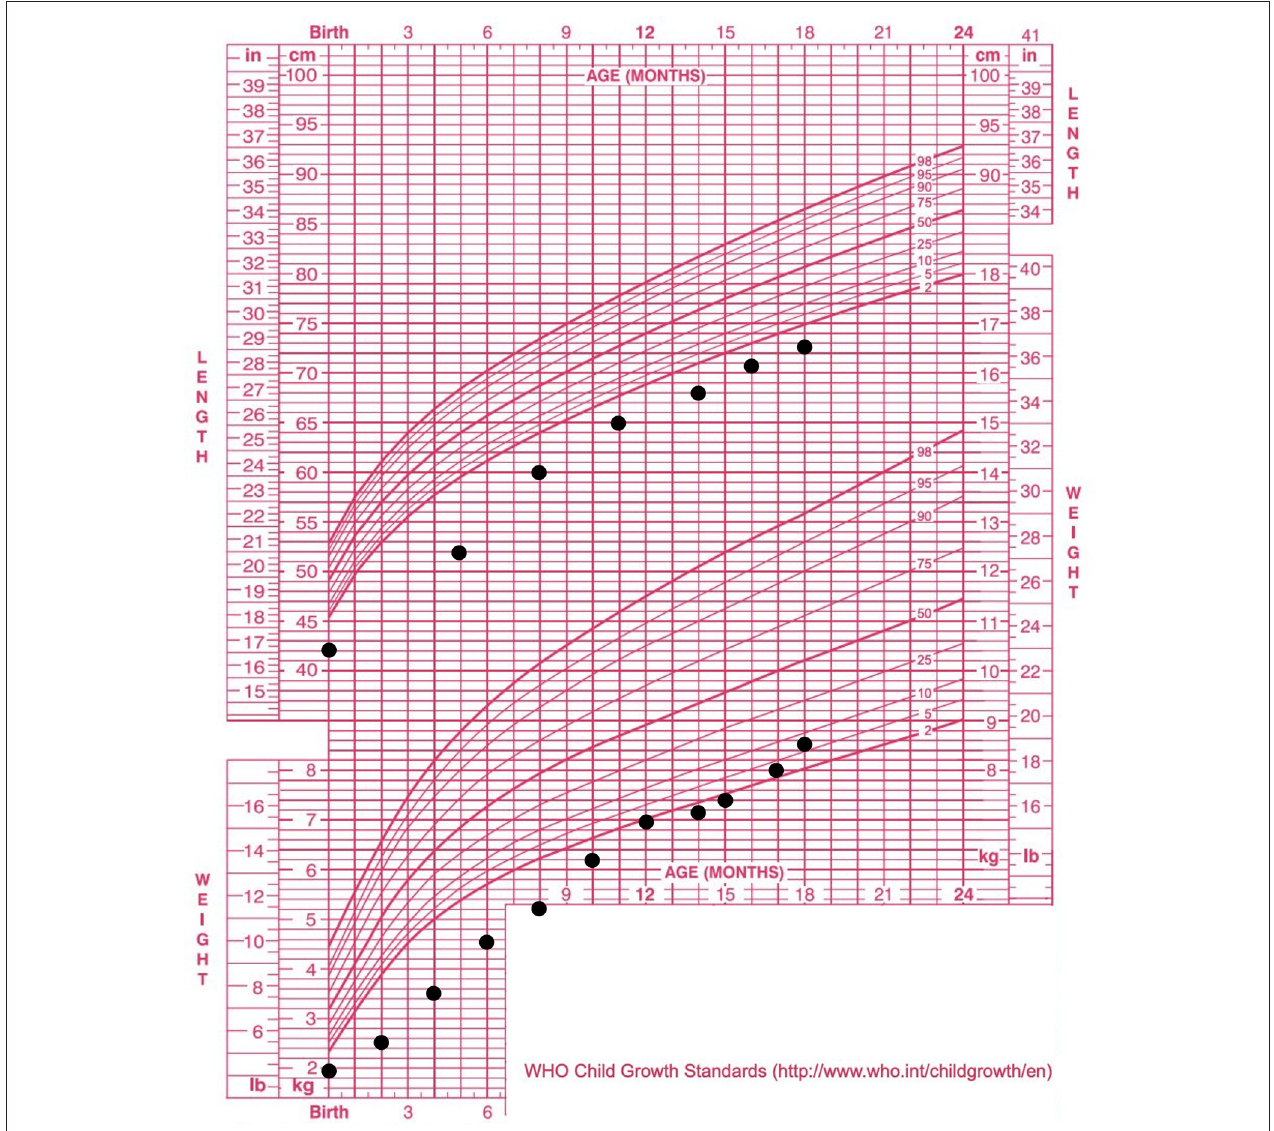
FIGURE 3 | Growth curve of the patient. Significant body weight percentile catch-up was observed, as she moved from lower than the 3rd percentile to the 3–10th percentile without extra parenteral nutrition. loop long enough to prevent ascending cholangitis is difficult